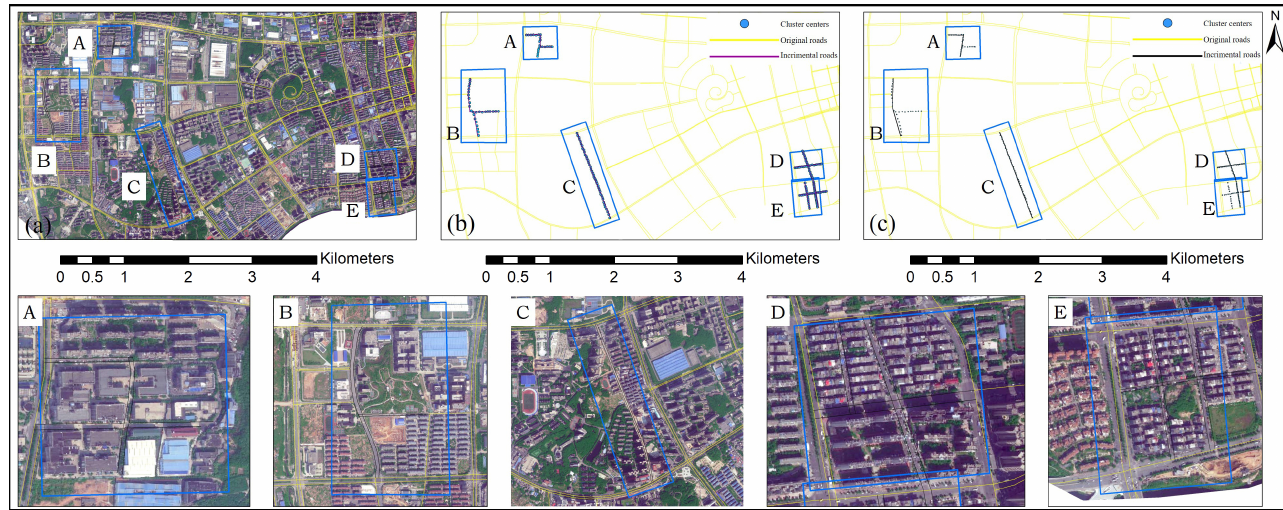
Figure 12. Updated results of the new road segments: ( a ) our method; ( b ) Deng et al.’s method (buffer size = 30 m); ( c ) Wu et al.’s method (cluster number = 200); and ( A – E ) partial enlarged drawings of updated